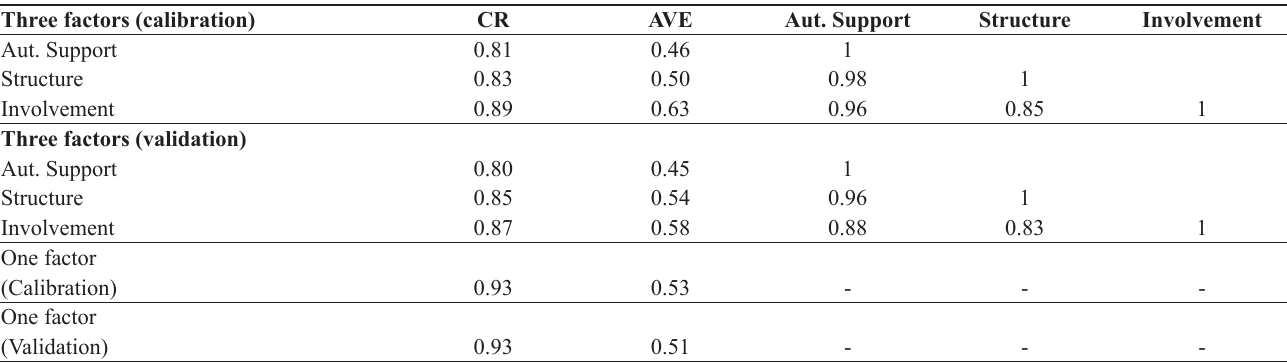
Table 3. Internal reliability, convergent and discriminant validity and average variance extracted – Calibration and Validation samples Three factors (calibration)